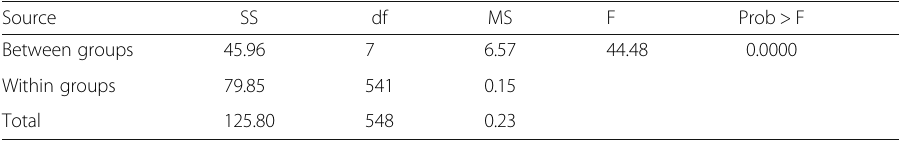
Table 2 One-way ANOVA results for perception scores Source